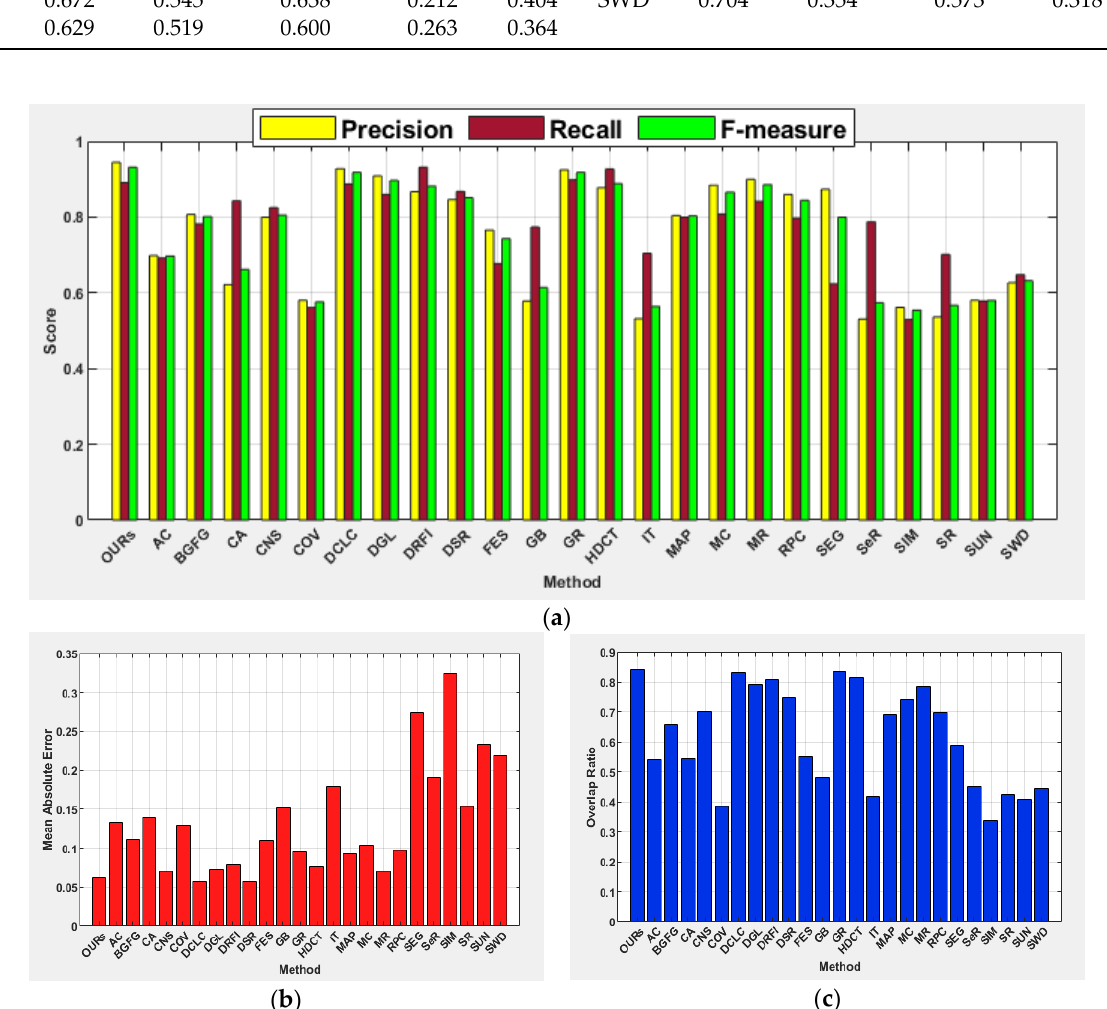
Figure 5. ( a ) F-measure; ( b ) MAR and ( c ) OR on image category: